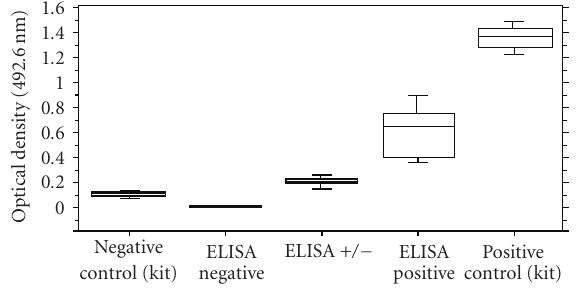
Figure 2: Serology-based assays: ELISA . Enzyme-linked immunosorbent assay (ELISA) absorbance values for antibodies to T. cruzi in monkey samples. Median values are indicated by horizontal lines within the boxes; the 25th and 75th percentiles are enclosed by the boxes; the 5th and 95th percentiles are enclosed by the bars outside the boxes. Adapted with permission of Comparative Medicine from [9].